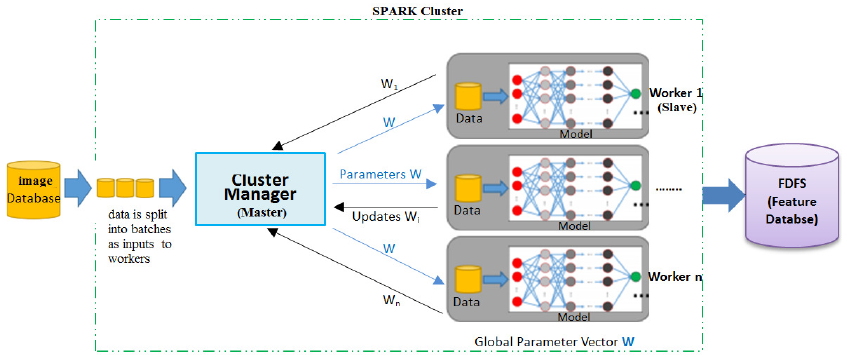
Figure 13. The proposed model for training and extracting object features using a distributed deep